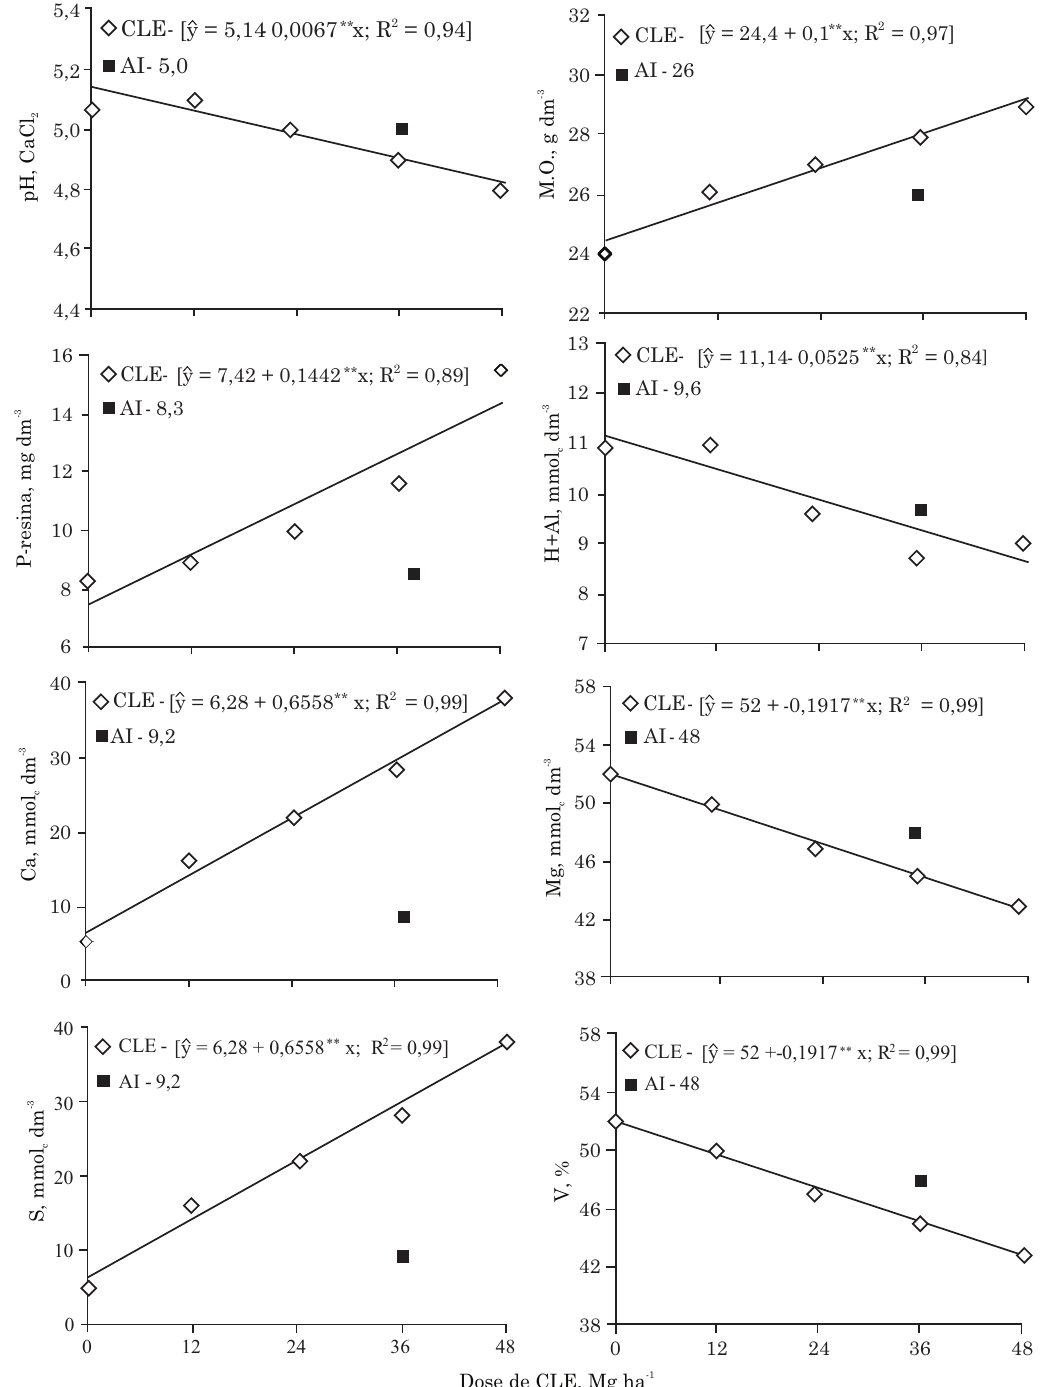
Figura 4. Características químicas do solo, na camada de 0-0,2 m, após o corte de tapetes da grama Imperial, em função de doses de composto de lodo de esgoto (CLE) e adubação inorgânica (AI), aos 13 meses após a aplicação do